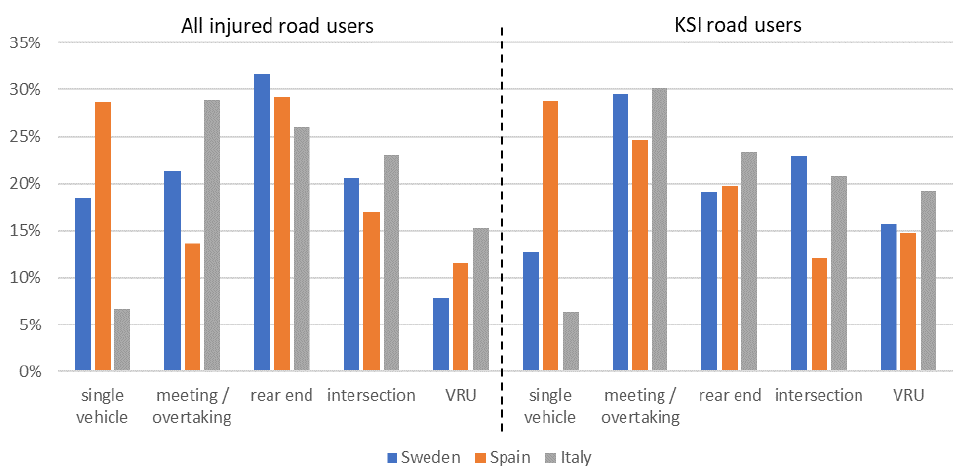
Figure 6. Distribution of crash scenarios for people injured in crashes with HGV involvement, separately for all injury levels and for KSI road users, based on the respective national crash